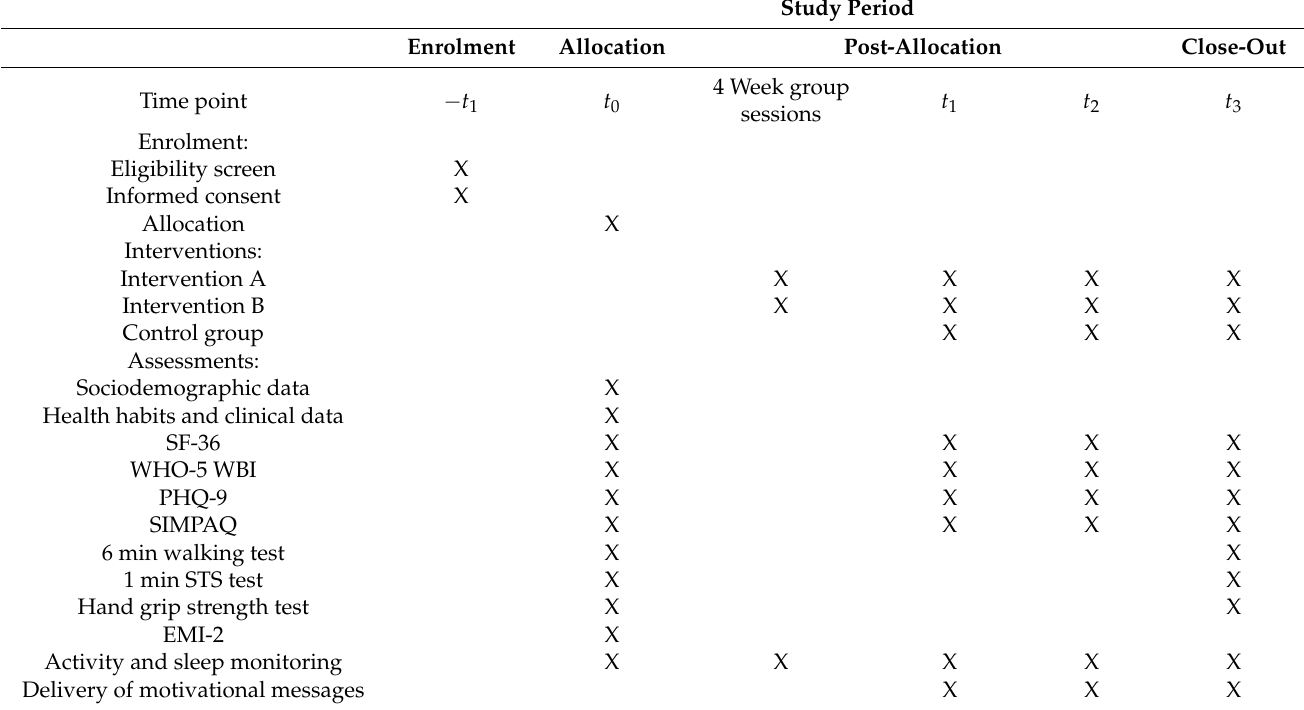
Table 2. SPIRIT diagram of the IDEA trial.